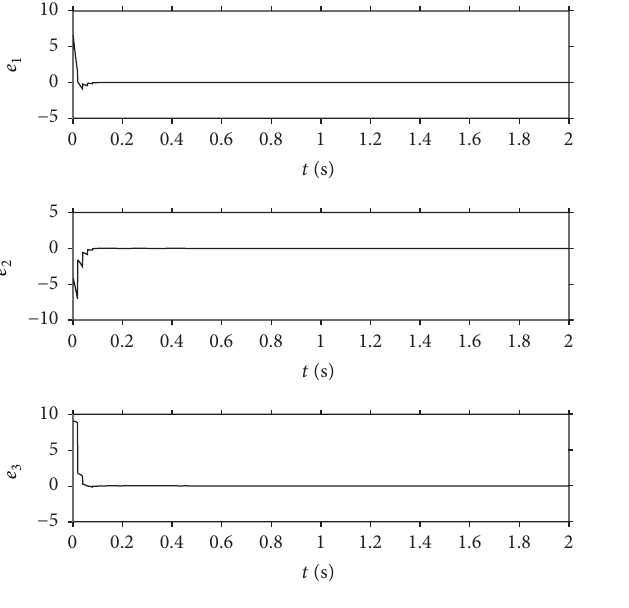
Figure 2: Time response of the error variable in case 1.